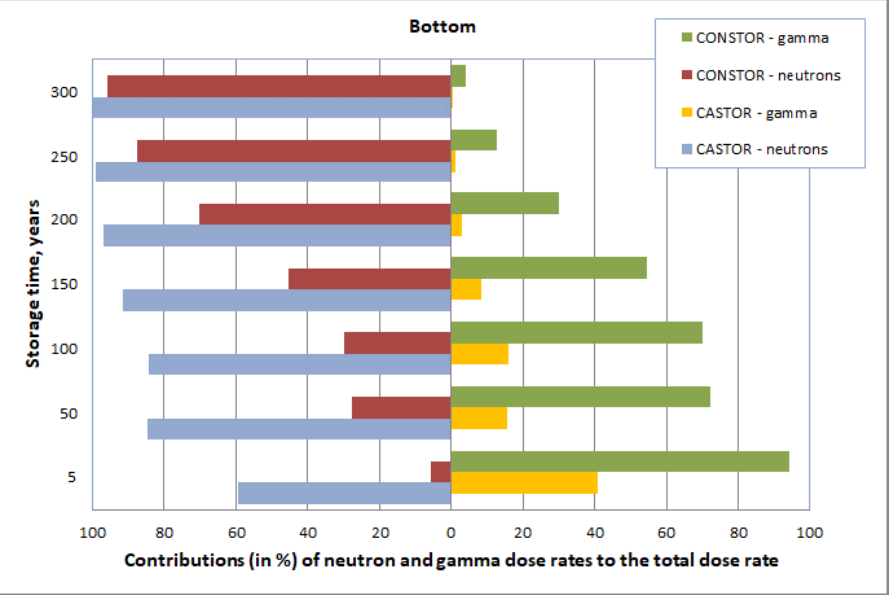
Figure 7. Neutron ( left ) and gamma ( right ) inputs to the total dose rate: bottom of the containers.